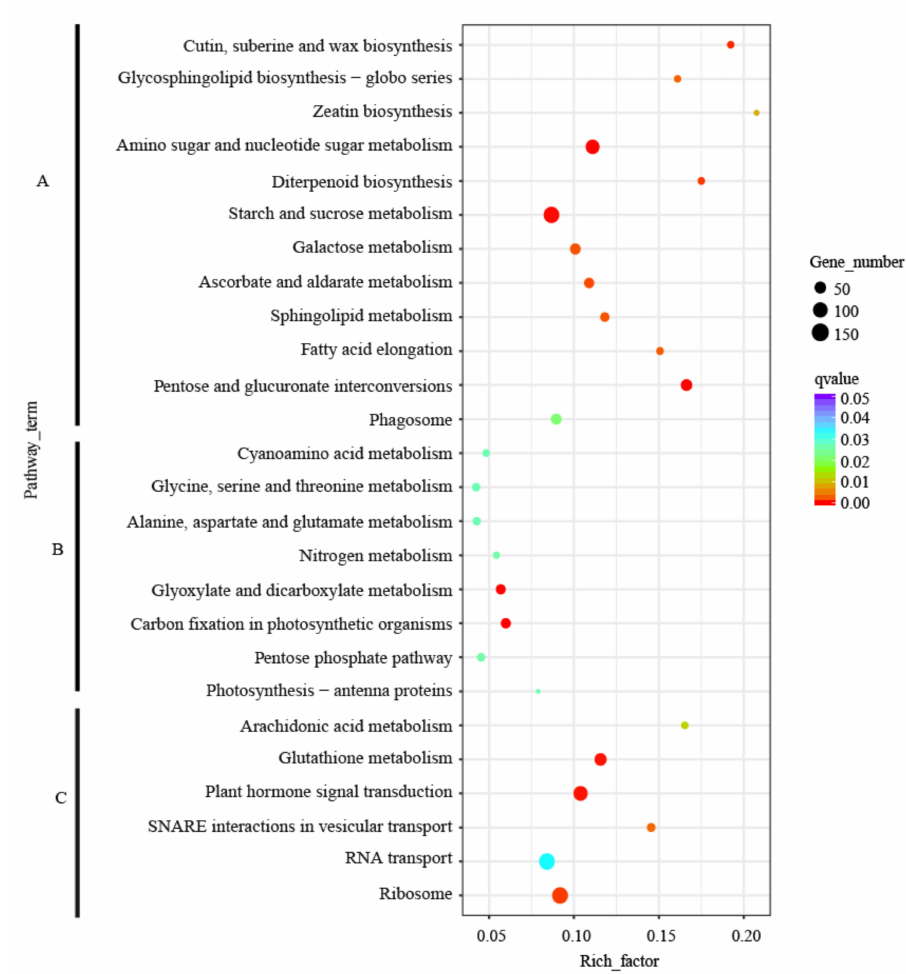
Figure 5. The Kyoto Encyclopedia of Genes and Genomes (KEGG) pathway enrichment analysis of tissue-specific expressed genes ( A ): male cone; ( B ): leaf; ( C ):